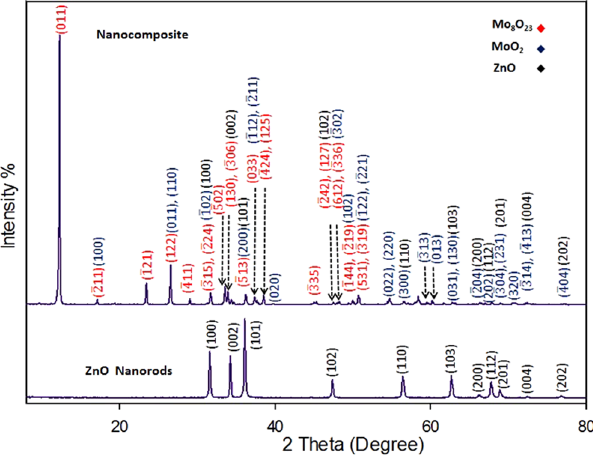
Figure 8. XRD patterns for ZnO nanorods and the nanocomposite (decorated ZnO nanoplatelets grafted Mo 8 O 23 -MoO 2 mixed